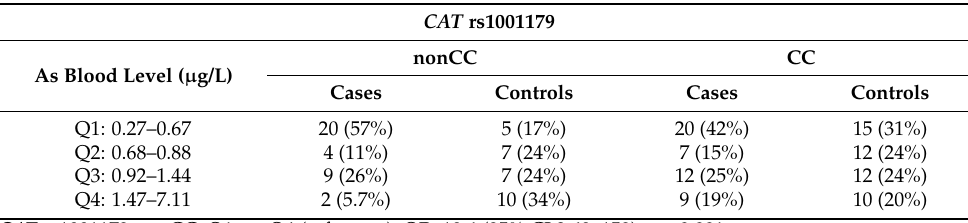
Table 3. Numbers of CRC cases and healthy controls depending on CAT gene polymorphism and blood-As concentration in women. CAT rs1001179 nonCC CC As Blood Level ( µ g/L) Cases Controls Cases Controls